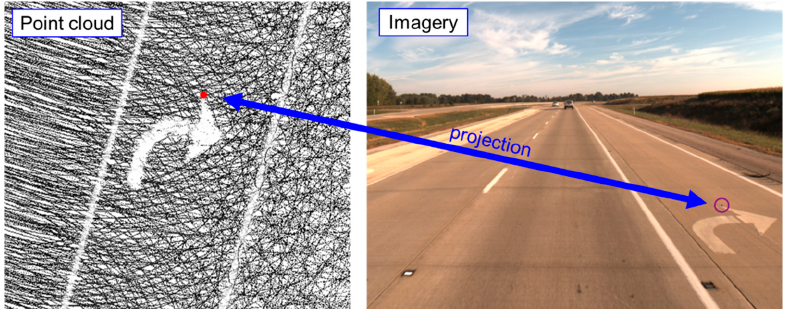
Figure 2. Projection of a location (red dot) in a Light Detection and Ranging (LiDAR) point cloud onto the corresponding RGB imagery (empty magenta circle) using the estimated LiDAR / camera / GNSS / IMU system calibration